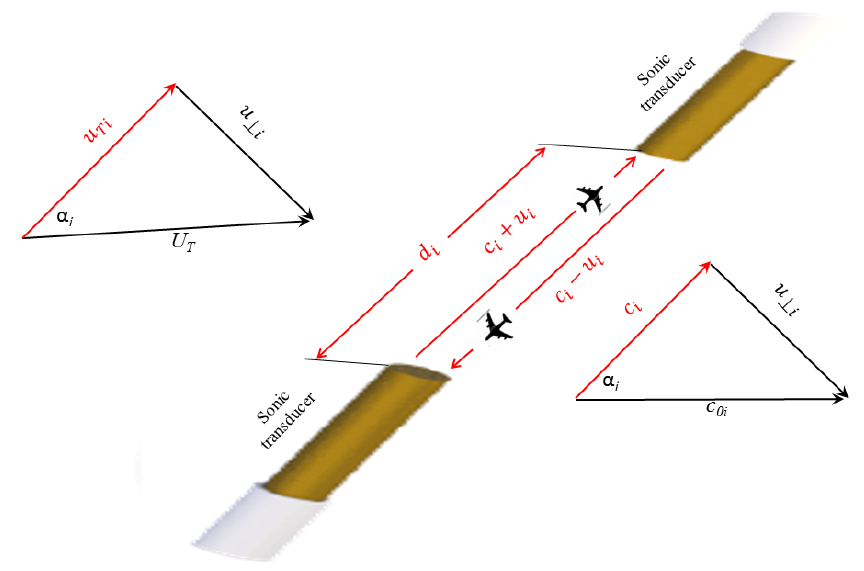
q q + u 2 u 2 u 2 x + u 2 y + u 2 z , where u x , u y , and u z are the wind ⊥ i or i